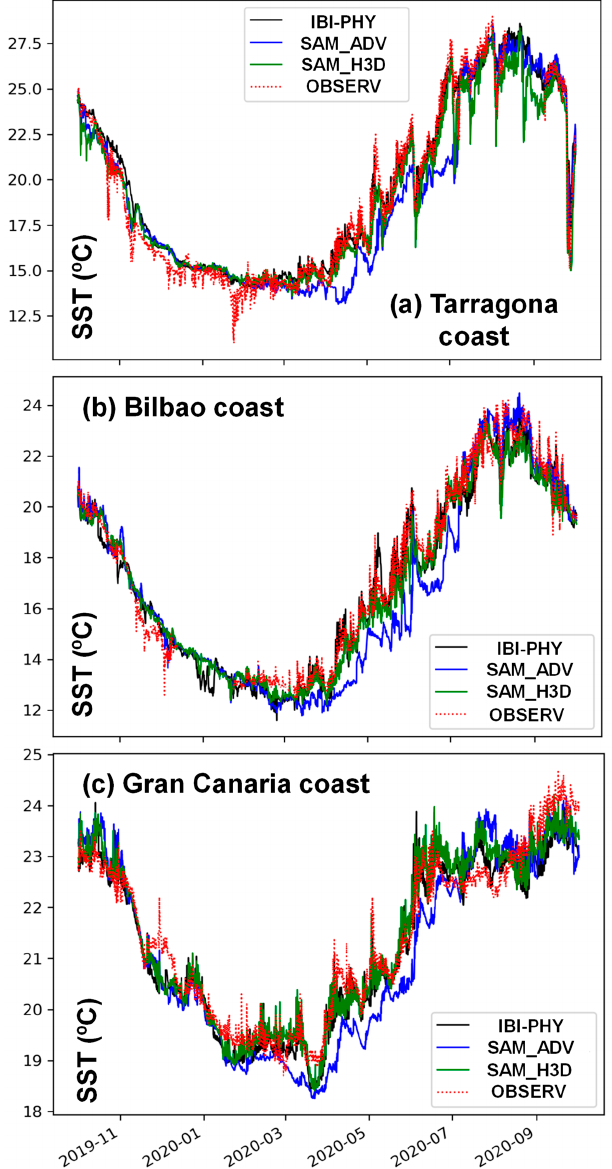
Figure 5. Observed and modelled Sea Surface Temperature (SST) at 3 coastal buoys. ( a ): Tarragona coast. ( b ): Bilbao coast. ( c ): Gran Canaria coast. Period shown: October 2019–October 2020. Units in Celsius degrees. The dotted red line represents the observations; the solid black line is the CMEMS IBI-MFC; the solid blue line is the current operational SAMOA set-up (SAM_ADV); the solid green line is the proposed set-up nested into hourly 3D IBI_PHY data (SAM_H3D). Further information about the buoy stations (location and mooring depth) can be found in Table